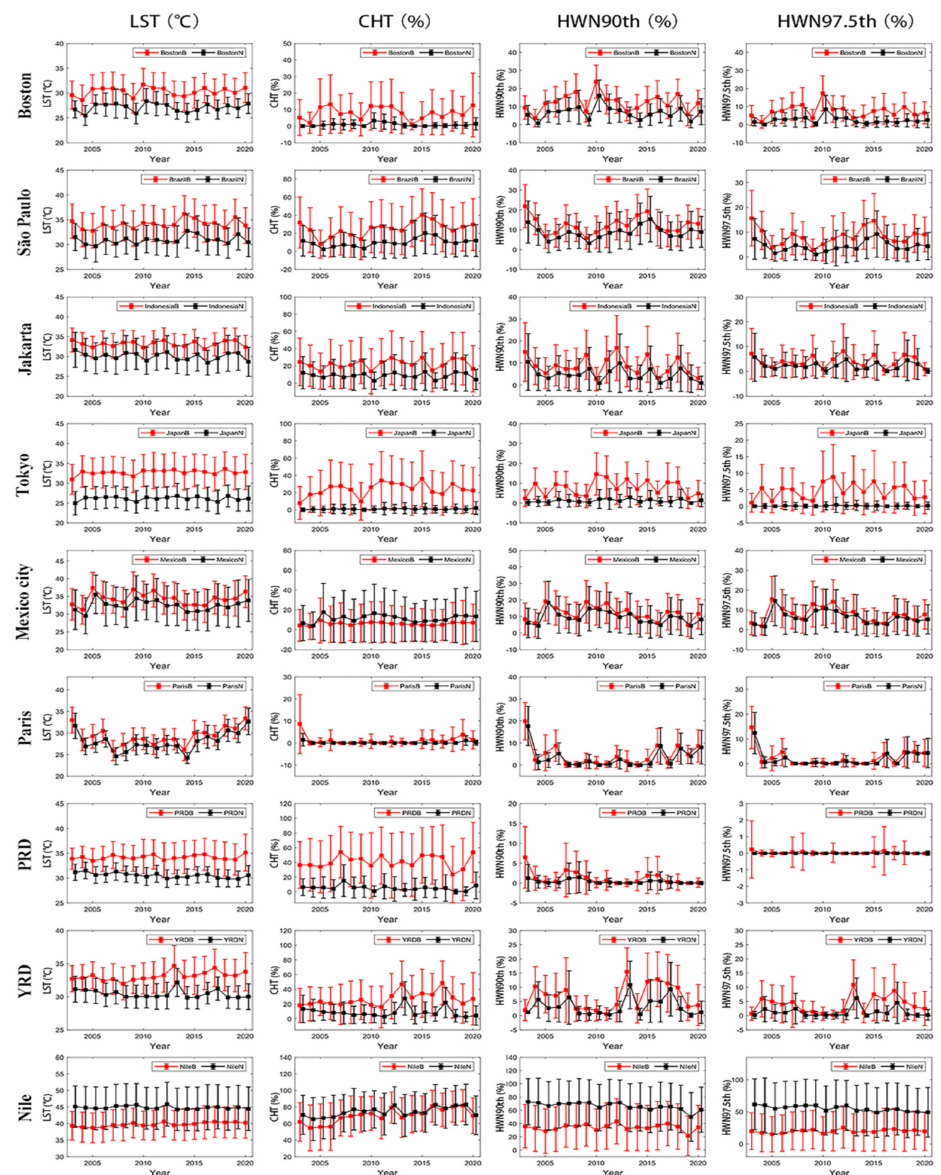
Figure 3. Time series of mean LST, CHT, HWN90th and HWN97.5th in the summer daytime from 2003 to 2020 in the 9 mega-regions in the built-up and Non-built-up areas. Error bars are graphical representations of the standard deviation of four indicators in the mega-region (B = Built-up area, N = Non-built-up